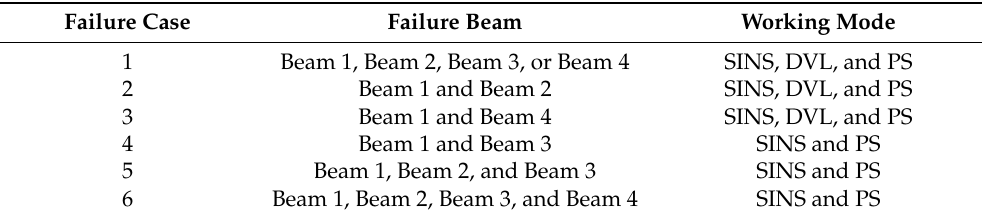
Table 4. The failure modes of the DVL beam and operation modes of the integrated navigation